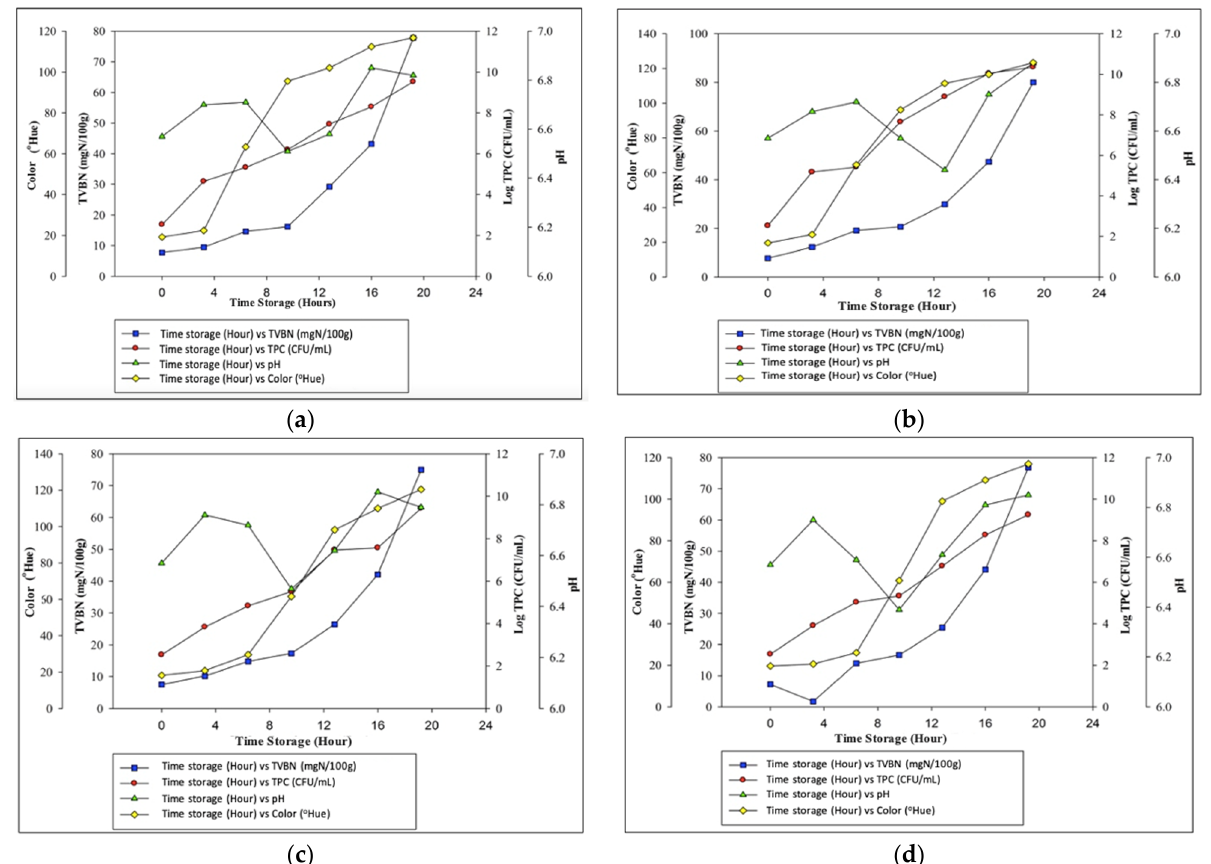
Figure 4. Correlations between changes in the color of the intelligent packaging indicator and the effects of the active packaging films with ( a ) 0%; ( b ) 5%; ( c ) 10%; and ( d ) 15% garlic extract on the parameters of quality deterioration of meat stored for 24 h.